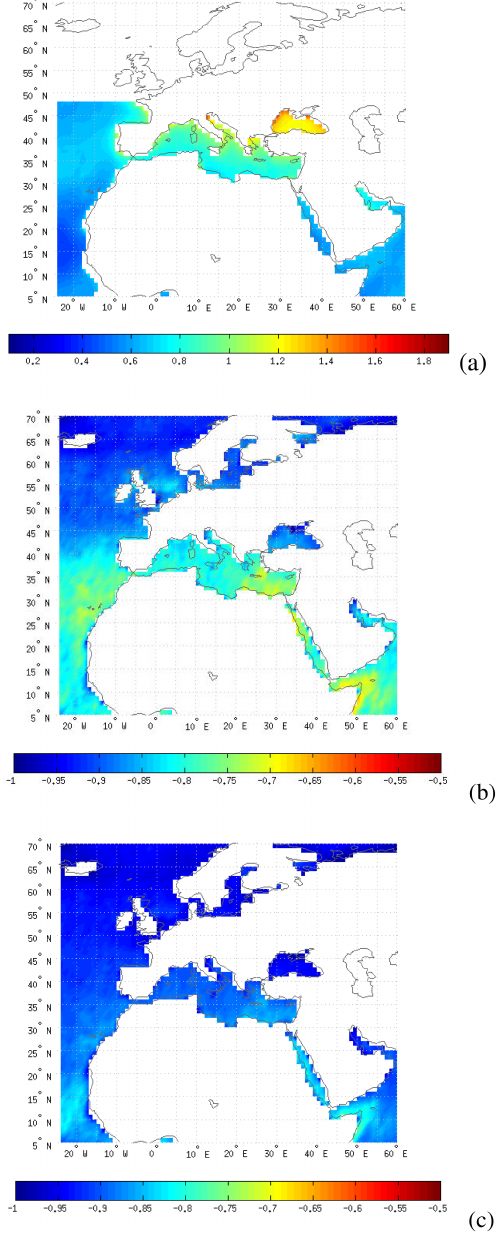
Figure 7. (a) Geographical distribution of MODIS-Aqua 051 Ångström exponent (AE 550 − 865 ) values averaged over 2002–2010, at the wavelength pair of 550–865nm. Winter AE data are miss- ing from the northernmost areas, and therefore the long-term av- erages in (a) are left blank. The correlation coefficients between AE 550 − 865 and g aer data at 660 and 860nm are given in (b) and (c) ,